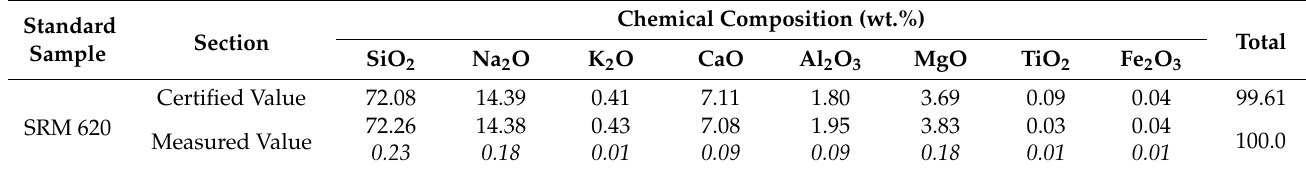
Table 1. Composition of the glass standard SRM 620.